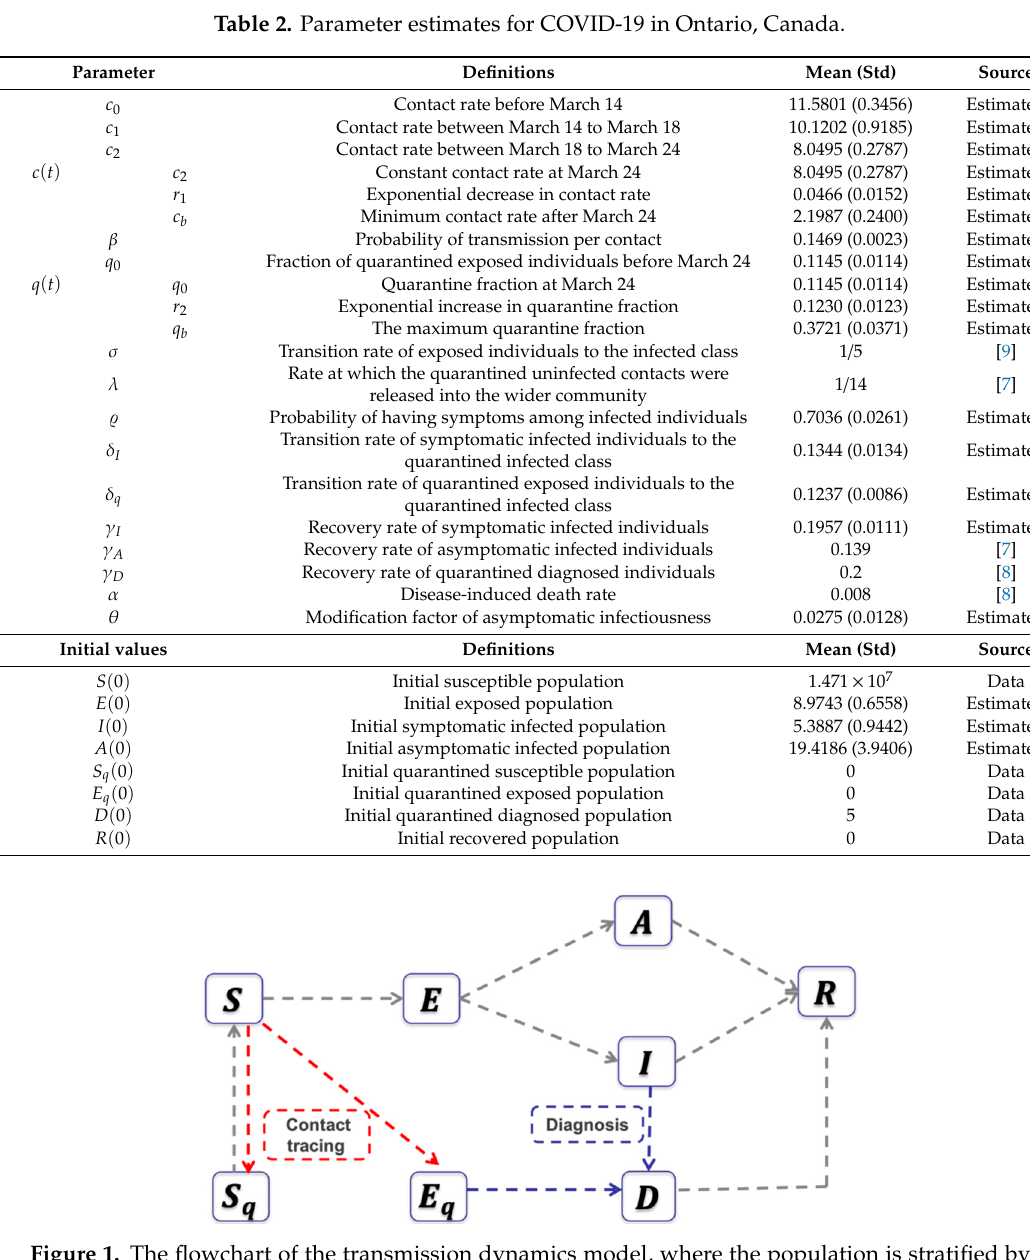
Figure 1. The flowchart of the transmission dynamics model, where the population is stratified by susceptible, exposed, asymptomatic infectious, symptomatic infectious, and recovered status, and by quarantine and isolation